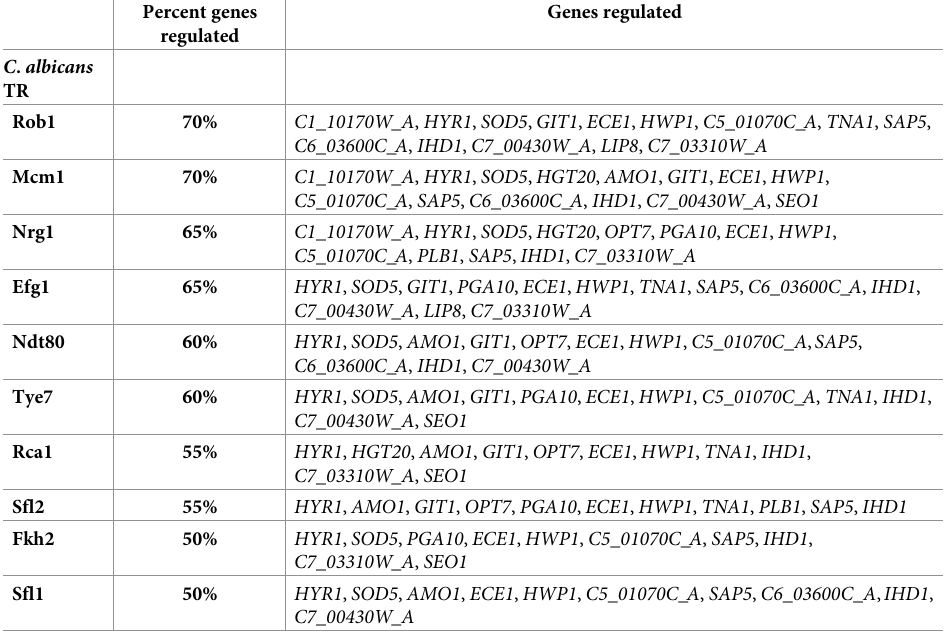
Table 2. Ten predicted microcolony transcriptional regulators. Twenty core C . albicans microcolony genes were analyzed using the PathoYeastract database to predict transcription factors that regulated at least half of the core micro- colony